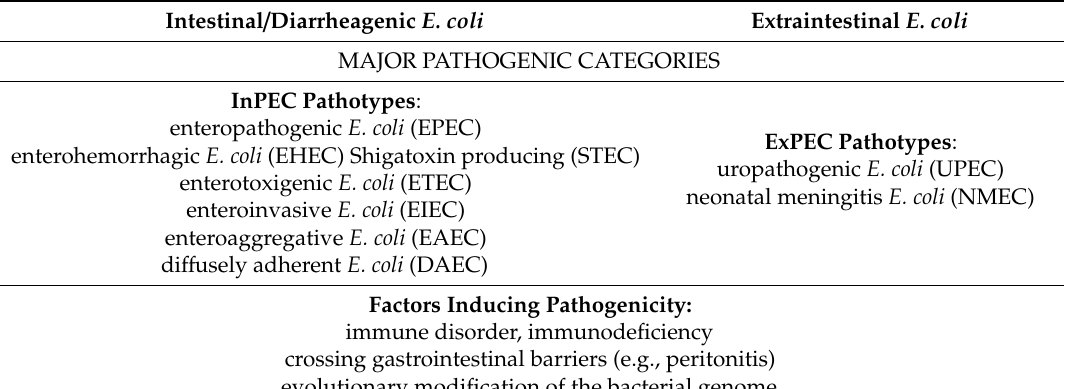
Table 2. Pathotypes of E. coli strains